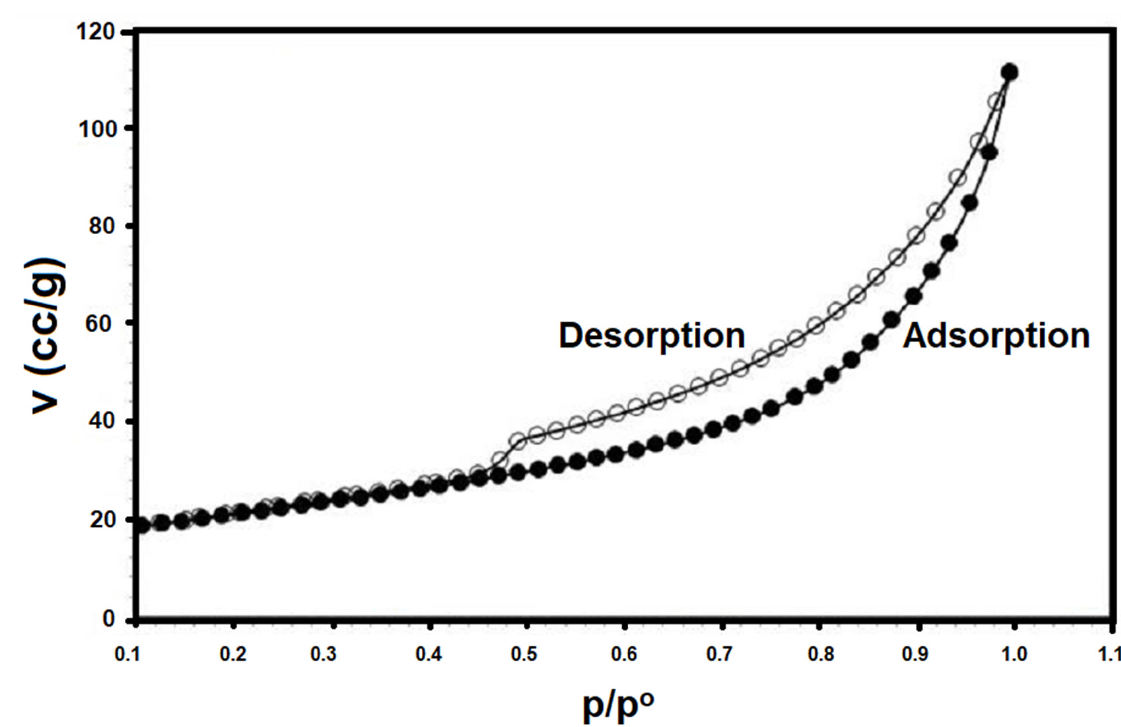
Figure 4. BET surface area of halloysite nanoclay at 77 K.